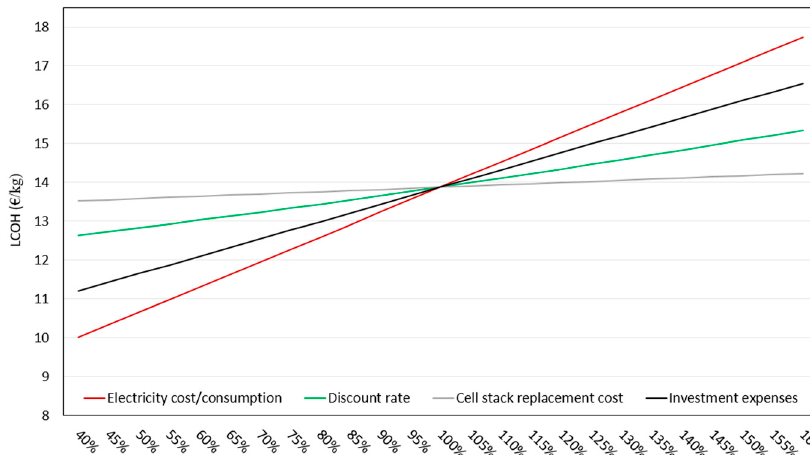
Figure 8. Sensitivity star for 20 years’ lifetime at 80% operating hours.